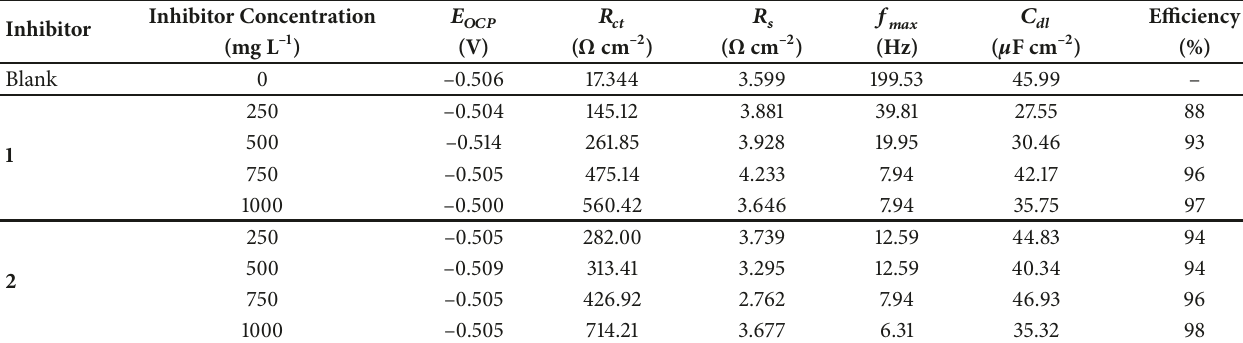
Table 8: Impedance data obtained from Nyquist diagram of carbon steel in 1.0 mol L – 1 HCl solution without and with inhibitors at different